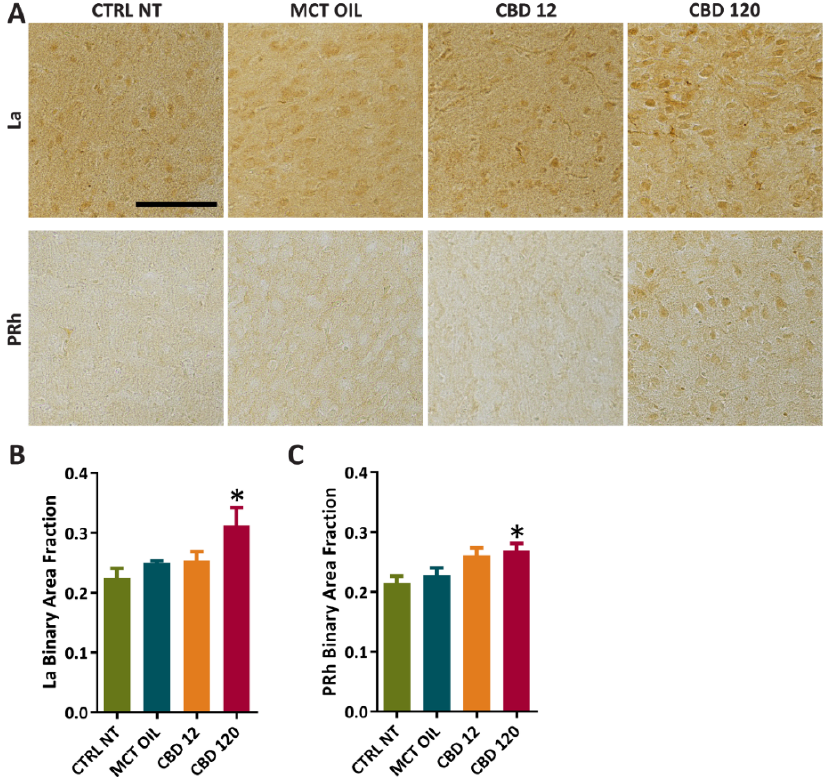
Figure 6. PPAR γ immunoreactivity in extrahippocampal regions of controls and rats treated with cannabidiol (CBD) or with medium ‐ chain triglyceride (MCT) oil. Non ‐ treated controls (CTRL NT, n = 6) and epileptic animals ( A ) treated with CBD at high dose (CBD 120, n = 6), CBD at low dose (CBD 12, n = 6), or MCT oil (MCT OIL, n = 6) were used to determine the levels of PPAR γ in lateral amygdala (La) ( B ), and perirhinal cortex (PRh) ( C ). * p < 0.05, CBD 120 vs. CTRL NT; Holm ‐ Šidák test. Scale: 0.1 mm.